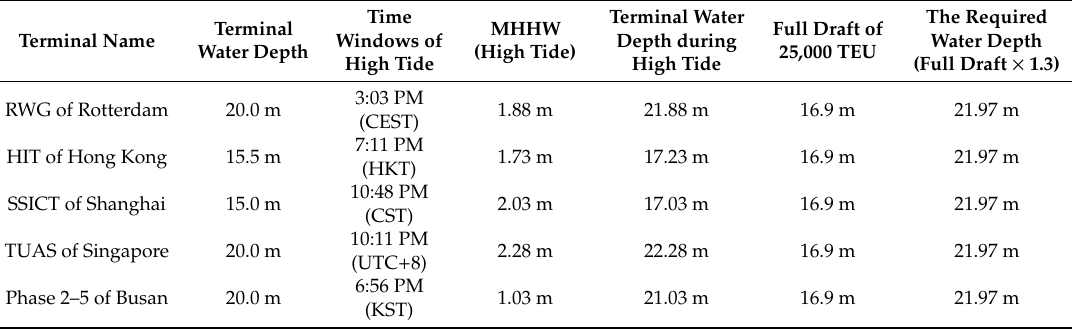
Table 9. Terminal Water Depth in High Tide and the Required Water Depth of 25,000